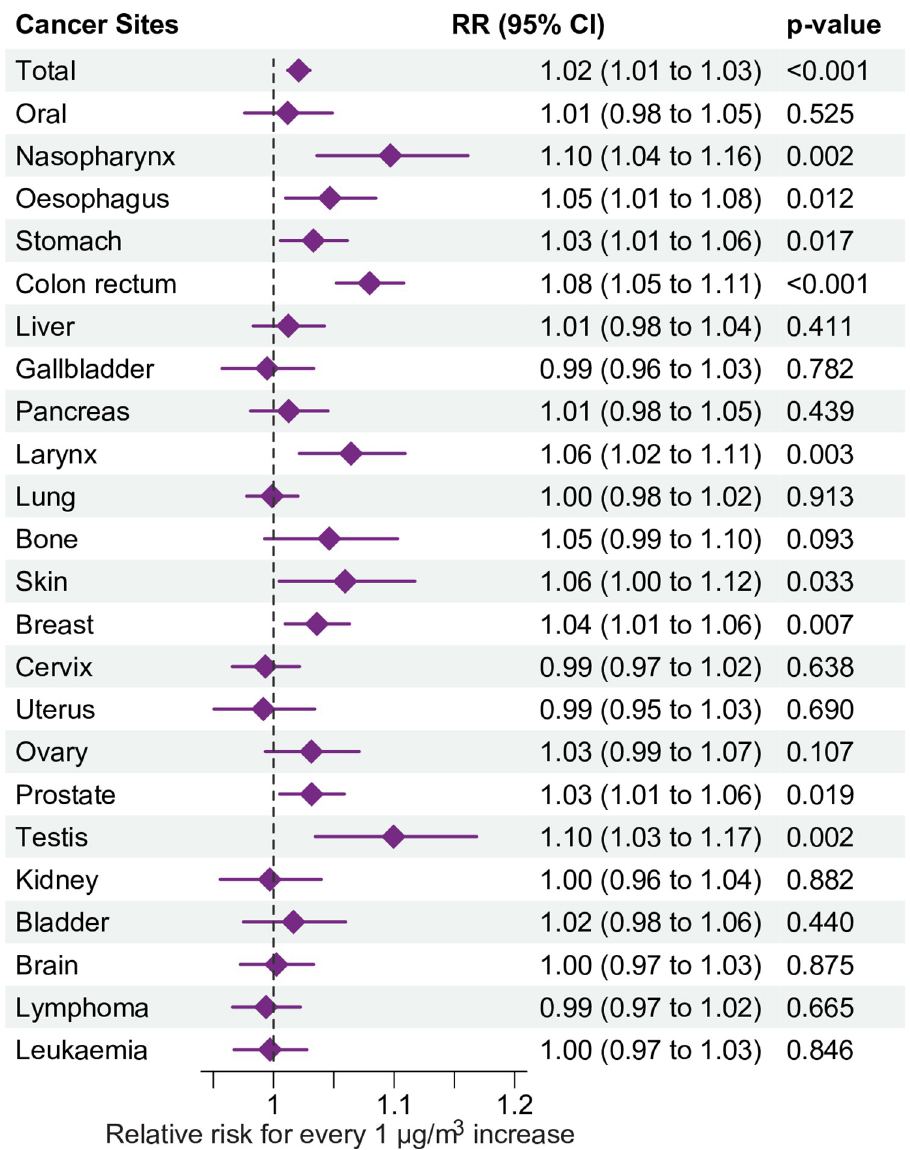
Fig 3. Estimated RRs and 95% CIs for the association between a 1- μ g/m 3 increase in 2-year average (lag0–1) wildfire-related PM 2.5 and all-cancer and site-specific cancer mortality, from 2010–2016. The vertical dashed line represents the reference line for RR = 1, helping to compare the effect estimates with the null hypothesis; the error bars represent 95% CIs. The model, by its design, controlled for factors that were stable across the study period or had similar trend across geographical locations, and also adjusted for spatial-temporal factors including seasonal temperature and GDP per capita. CI, confidence interval; RR, relative